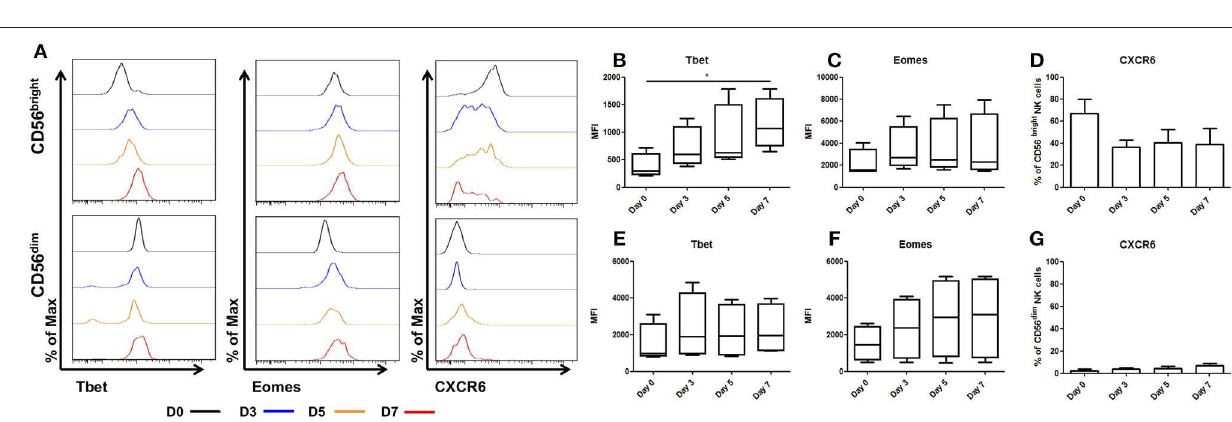
Figure 4B ). At day 0 the MFI of Eomes was 1,514 ± 237.1 for CD56 bright cells, by day 7 the MFI had increased to 2,371 ± 267